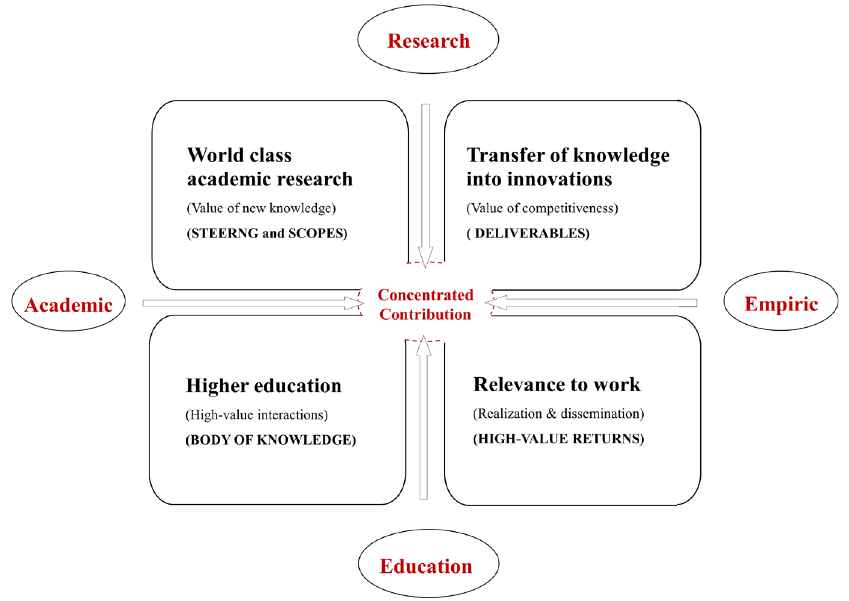
Fig. 1. The revised concept of value concentration (Pirinen, 2013